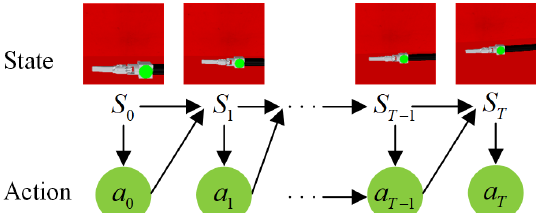
Figure 5. Markov model of laparoscopic visual field